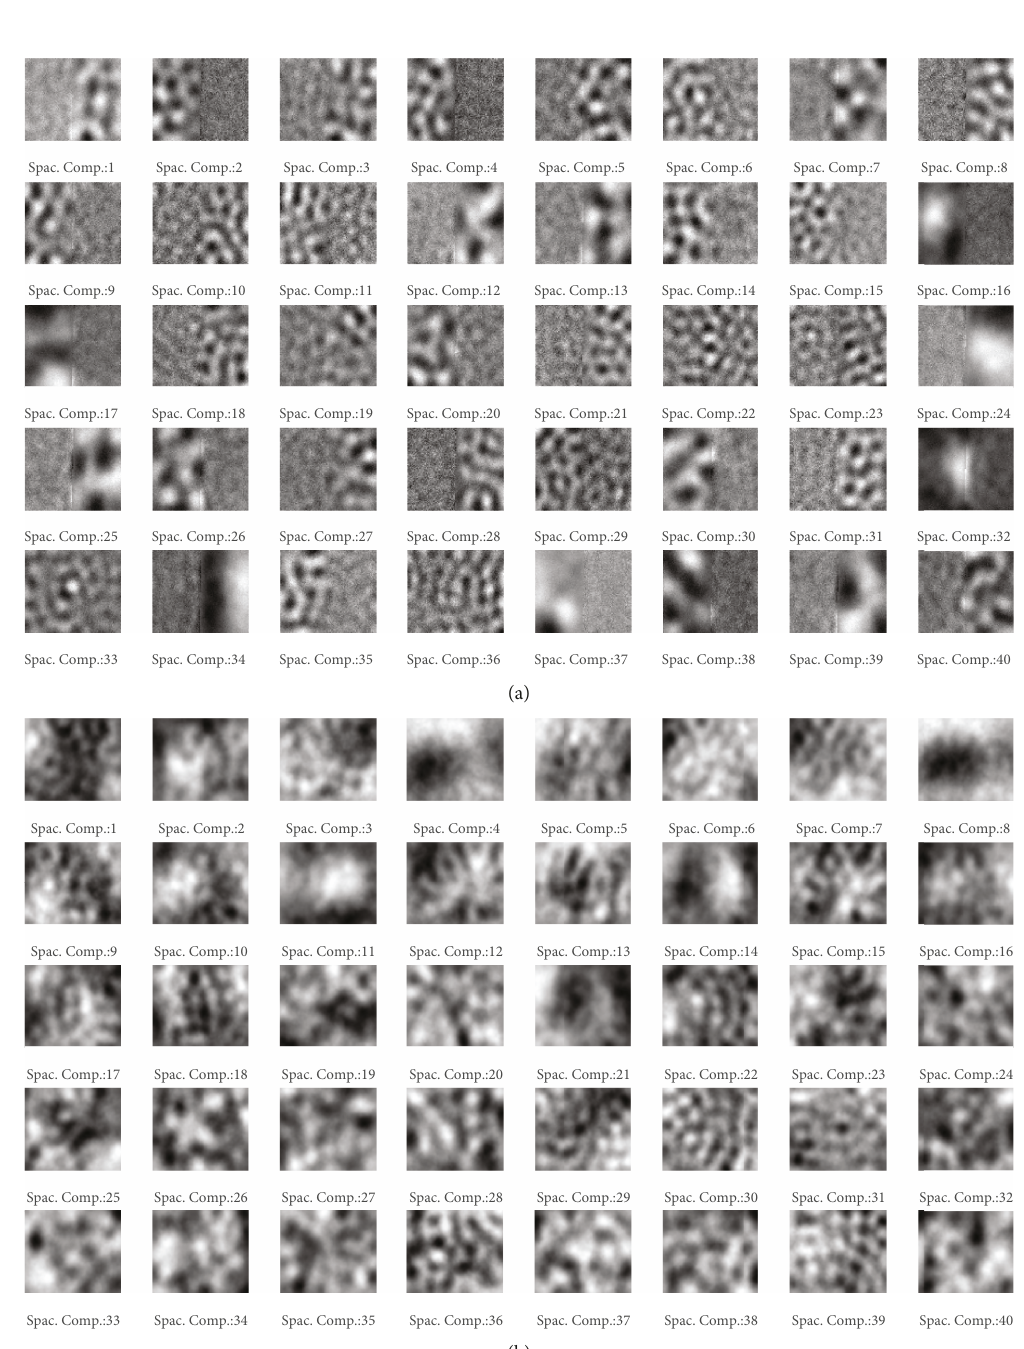
ALS algorithm from full data and the StrProxSGD algorithm